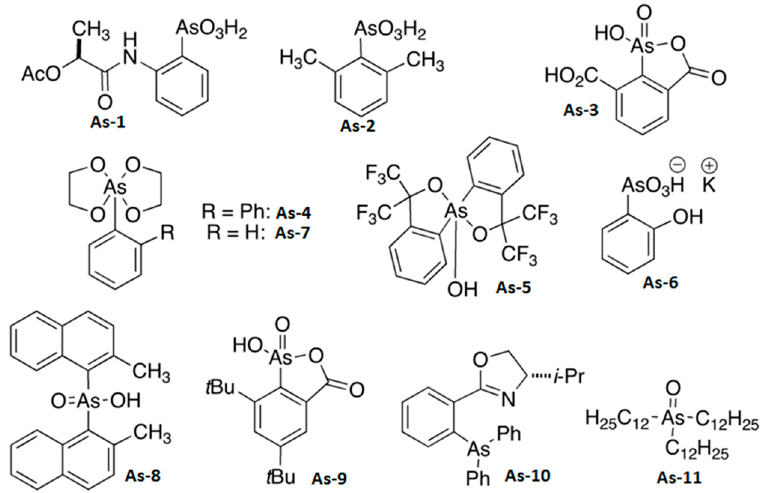
Figure 2. Chemical structure of synthesized organoarsenic compounds tested in the study.